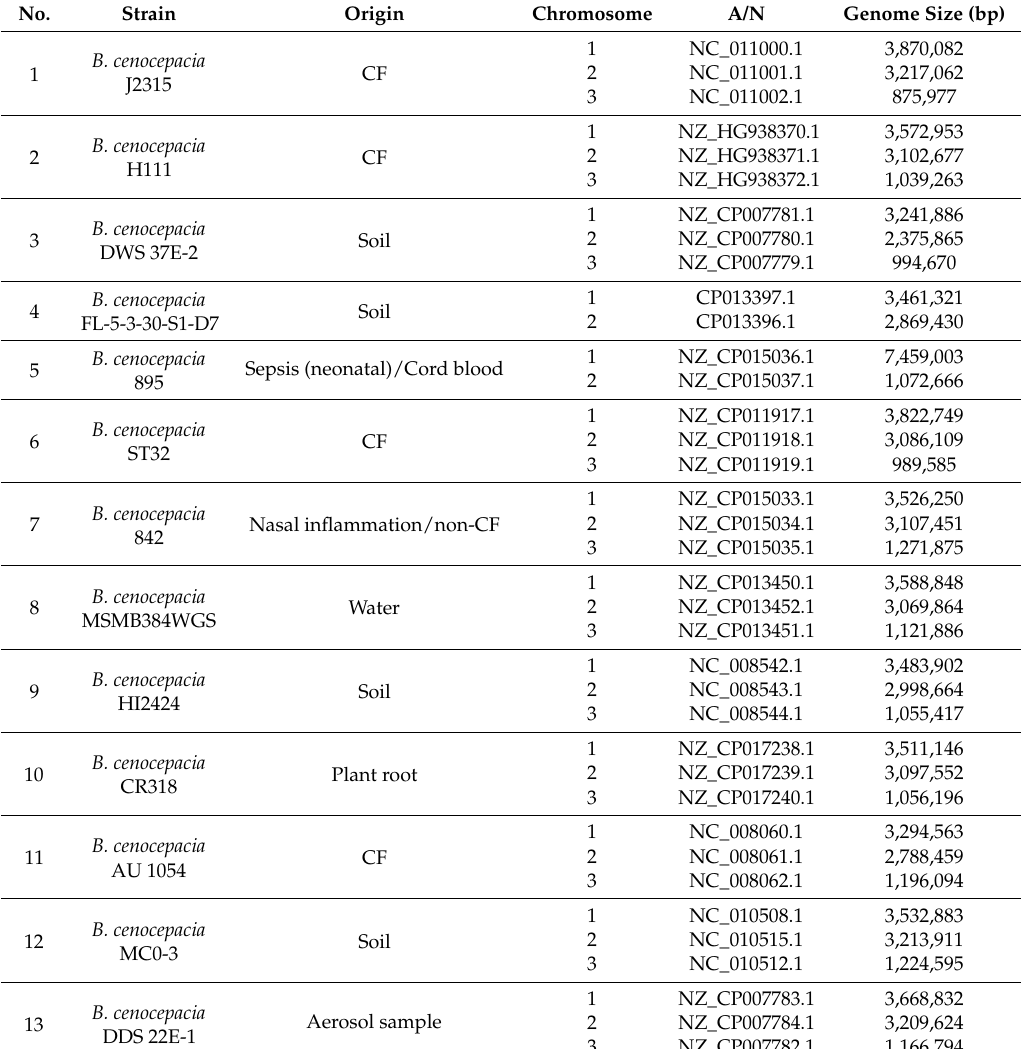
Table 1. B. cenocepacia strains chosen for